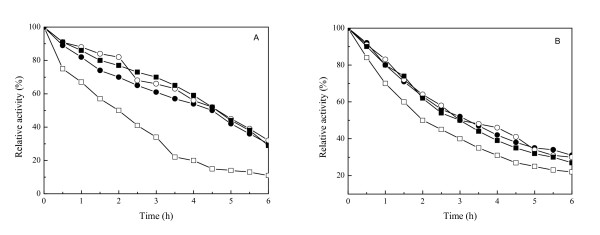
Thermostability of native and modified CPOs at 50°C in aqueous buffer. A: peroxidase activity; B: Sulfoxidation activity. CPO (■); CA-CPO (●); MA-CPO (□); PA-CPO (○). The values represent the mean of three independent sets of experiments with SD < 5%.